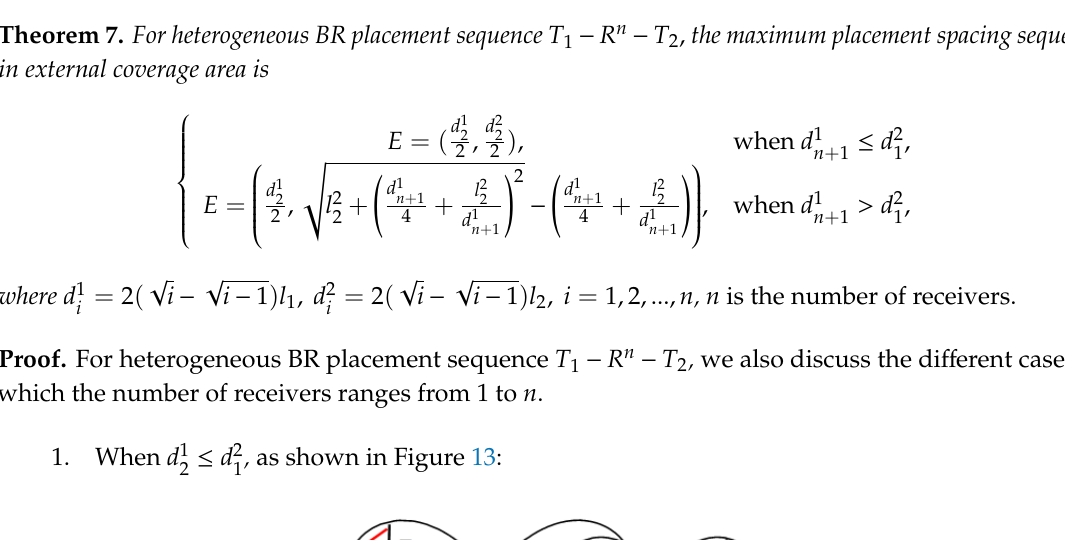
Figure 13. External coverage area of heterogeneous BR sequence ( T 1 , T 2 ) when d 1